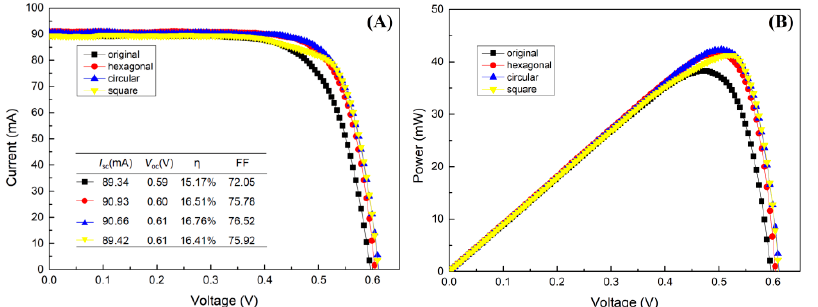
Figure 9. ( A ) I-V curves and ( B ) P-V curves of silicon solar cells with square MLAs, circular hexagonal MLAs, and a circular MLAs structure, compared to those of a bare cell.